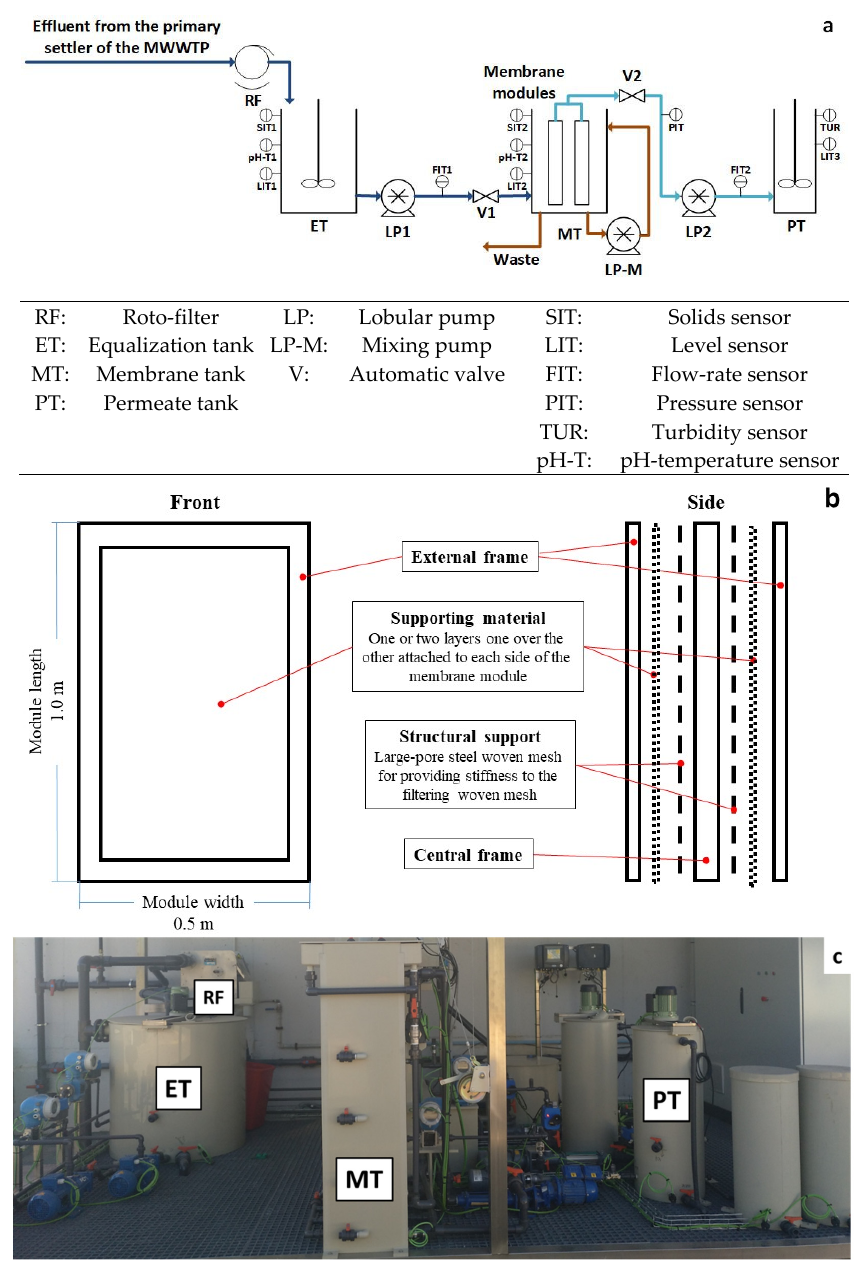
Figure 1. DM pilot-plant: ( a ) diagram scheme, ( b ) membrane module scheme and ( c ) picture. The pilot plant was operated continuously at a given operating flux (see Table 2), performing filtration-relaxation cycles with a ratio of 3:1 min. The two membrane mod- ules were connected to a lobular pump (PCM, M series, EcoMoineau™, Milano, Italy) for vacuum filtration. A lobular pump continuously mixed the concentrated sludge to ensure